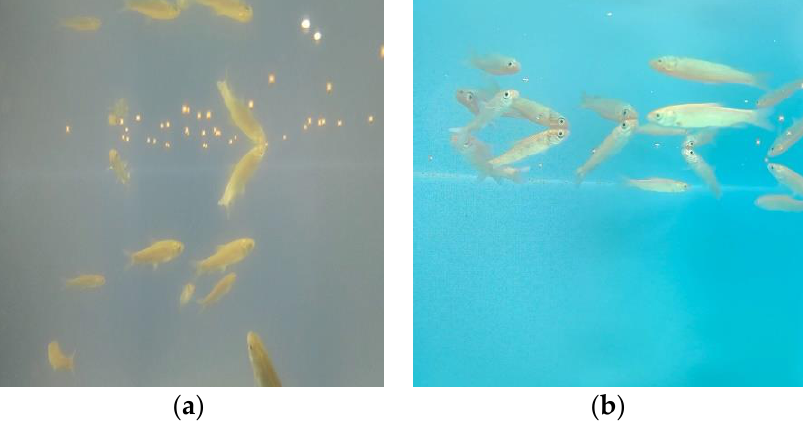
Figure 3. Images of fry feeding acquired in shallow underwater: ( a ) image acquired in sunny conditions; ( b ) image acquired in cloudy conditions.